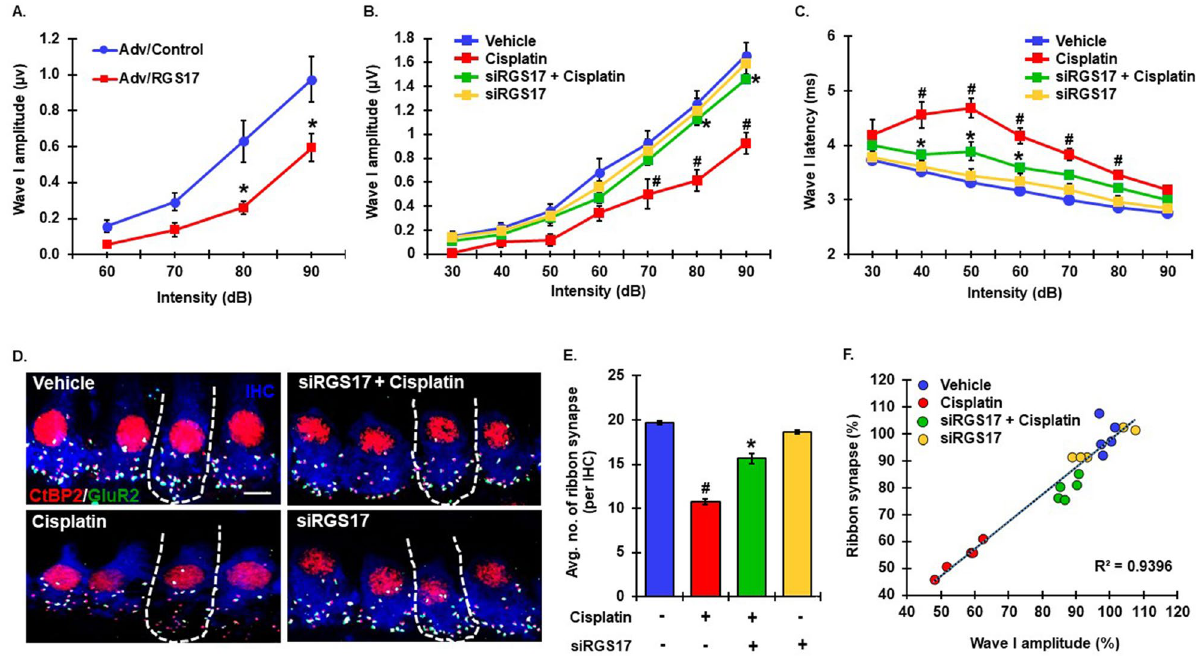
Figure 4. RGS17 regulates cochlear synaptopathy. ( A ) Male Wistar rats were administered adenoviral vector overexpressing RGS17 or empty viral vector by the trans-tympanic route. Post ABRs were performed 5 days after the treatment. Wave I amplitudes were measured manually at 32 kHz for 60, 70, 80 and 90-dB intensities. RGS17 overexpression significantly decreased wave I amplitudes at 80 and 90-dB. Data indicates mean ± SEM, *p < 0.05 versus adenovirus/control, N = 10, two-way ANOVA. ( B ) Naïve male Wistar rats were treated with siRGS17 (0.9 μg/ear) 2 days prior to cisplatin administration. Post-treatment ABRs were performed 3 days after cisplatin exposure and wave I amplitude was measured at 32 kHz for 30–90 dB intensities. Rats were divided into 4 treatment groups, vehicle (blue line), cisplatin (red line), siRGS17 pretreatment + cisplatin (green line) and siRGS17 alone (yellow line) alone. Cisplatin produced a significant decrease in wave I amplitude at 70, 80 and 90-dB intensities whereas knock down of RGS17 prior to cisplatin significantly abrogated this response at 80 and 90-dB, compared to cisplatin treated rats. Data represents mean ± SEM, # p < 0.01 versus vehicle, *p < 0.01 versus cisplatin, N = 12, two-way ANOVA. ( C ) In the same group of animals, cisplatin treatment significantly increased Wave I latencies at 32 kHz for 40–80 dB intensities but pretreatment of siRGS17 significantly decreased wave I latencies at 40, 50 and 60-dB. Data represents mean ± SEM, # p < 0.05 versus vehicle, *p < 0.05 versus cisplatin, N = 12, two-way ANOVA. ( D ) The cochleae collected from rats after ABRs were micro-dissected and co-stained with antibody against Myo7a (blue), CtBP2 (red) and GluR2 (green) for immunofluorescence assays. Representative images are taken at the level of IHCs from the basal region of the cochleae. Colocalization of CtBP2 (red) and GluR2 (green) on a background of Myo7a (blue) merge together to give bright white puncta which represents functional ribbon synapse at IHCs. Cisplatin treatment decreased the abundance of white punctae but pretreatment of siRGS17 preserved the number of white punctae. Both vehicle and siRGS17 treated cochleae displayed normal number of white puncta. ( E ) Presence of white puncta was manually counted and represented in the graph as the the average number of functional ribbon synapses per IHC. Cisplatin significantly decreased the average number of functional synapses at IHC as compared to siRGS17 pretreated cochleae. Data plotted represents average mean of functional synapse ± SEM (N ≥ 4). #p < 0.05 compared to vehicle, *p < 0.05 compared to cisplatin, N = 4, two way ANOVA ( F ) ABR Wave I amplitudes (at 90 dB) collected from ( B ) and synaptic count from ( D ) were normalized with respect to the mean values in their vehicle controls. Correlation graph was plotted for these two parameters which shows high correlation between them with R 2 = 0.94. Data represents N =